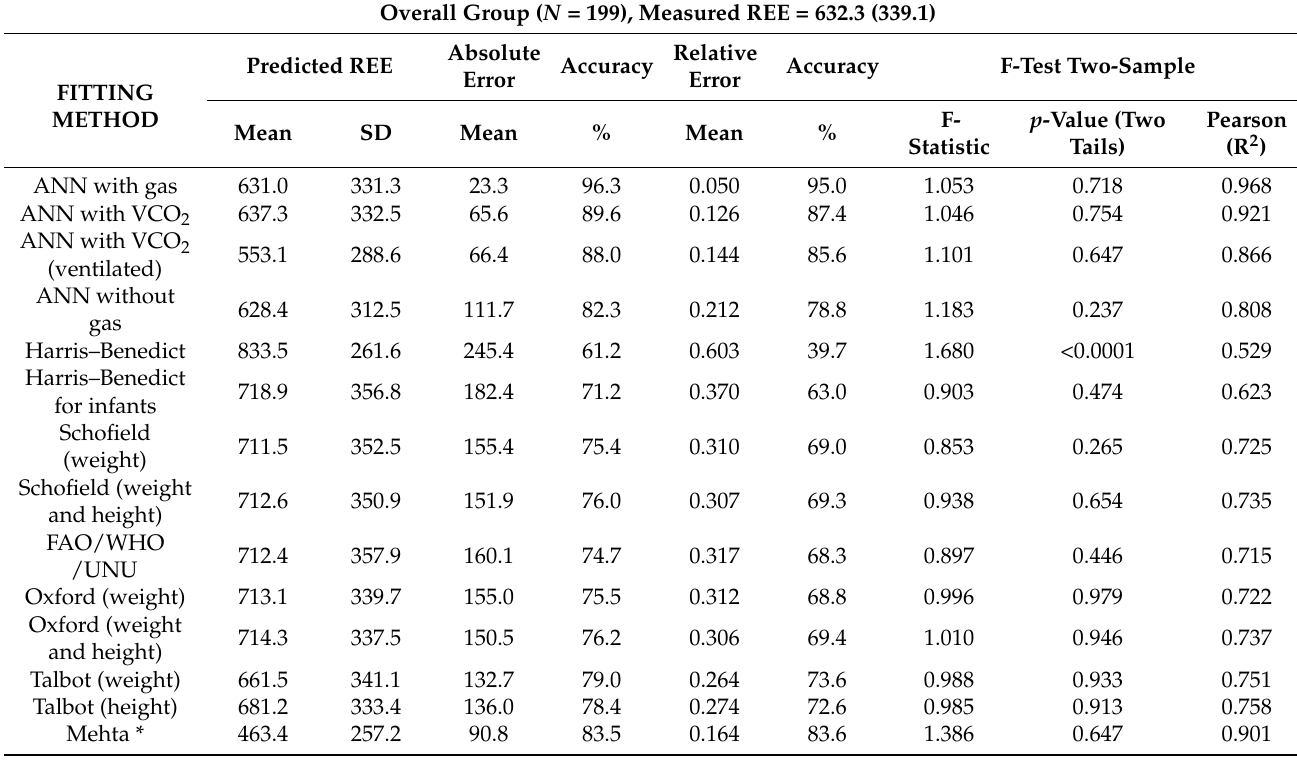
Table 5. Fitting performances of true REE by the methods under